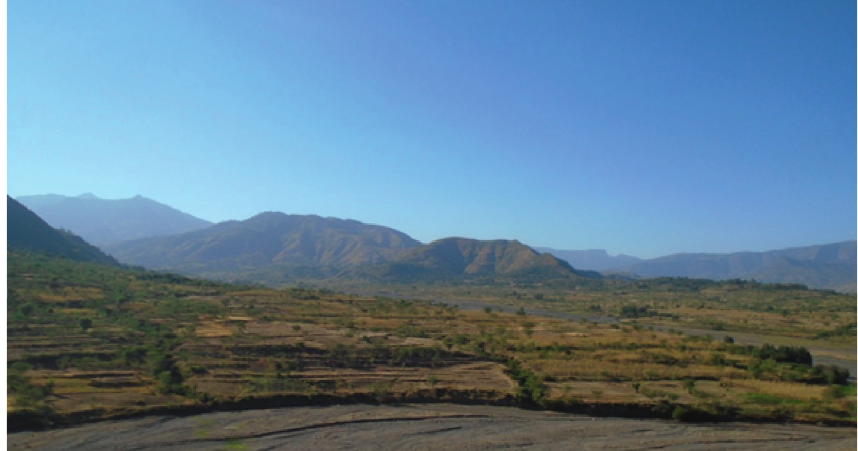
Figure 2: Jarsa kebele research site.